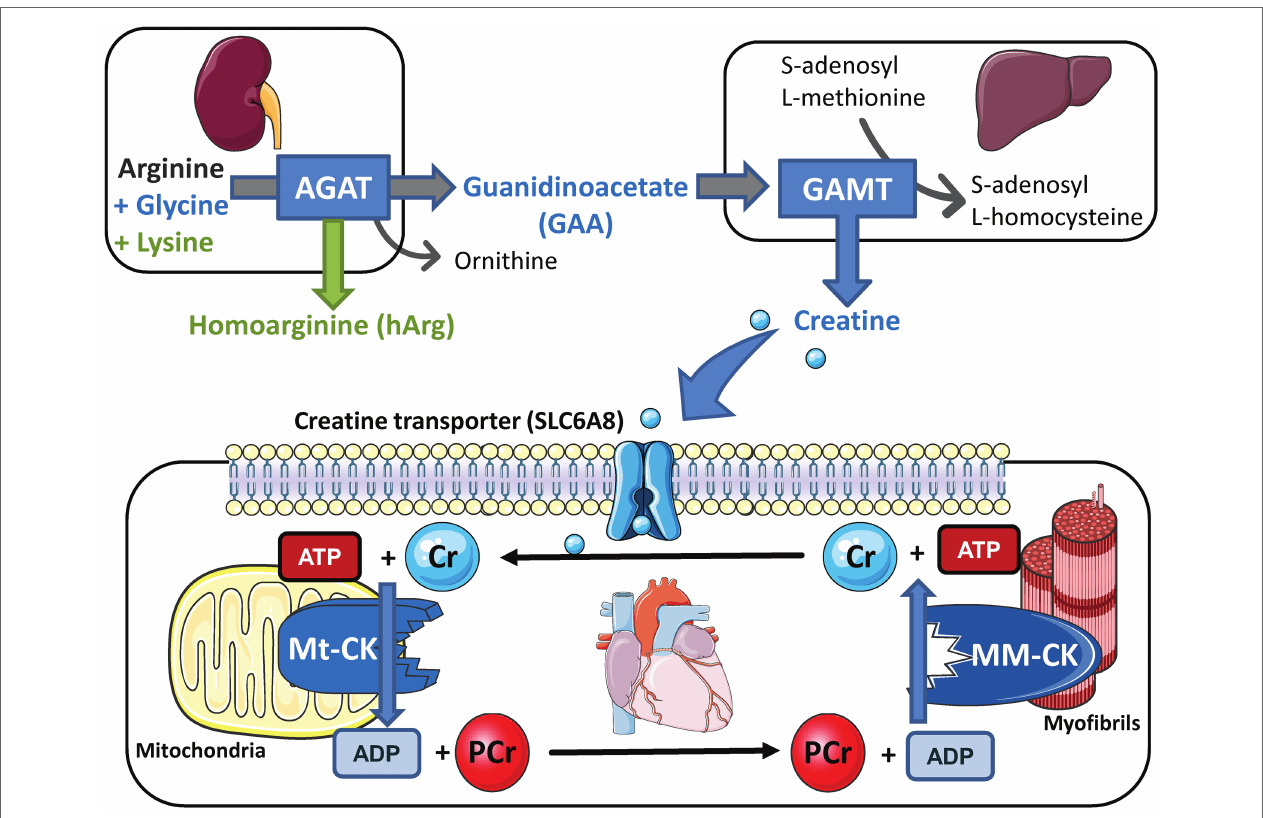
FIGURE 1 | Creatine biosynthesis and the myocardial creatine kinase (CK) phosphagen system. Arginine:glycine amidinotransferase (AGAT; EC 2.1.4.1) is predominantly expressed in the kidneys where it combines arginine and glycine to make guanidinoacetate (GAA) or with lysine to make homoarginine (hArg). Circulating GAA is taken up by the liver where GAA N-methyltransferase (GAMT; EC 2.1.1.2) utilises the methyl group from S-adenosyl L-methionine to synthesise creatine. These biosynthetic enzymes are not expressed in cardiomyocytes so creatine must be taken-up via a specific plasma membrane creatine transporter (SLC6A8). Creatine accumulates inside the cell where the sarcomeric mitochondrial isoform of creatine kinase (MtCK; EC:2.7.3.2) catalyses the transfer of a phosphoryl group from ATP to form phosphocreatine (PCr) and ADP. PCr is a high abundance and mobile energy source that can be utilised to rapidly regenerate ATP at times of high demand under the control of the muscle isoform of creatine kinase (the dimer MMCK; EC 2.7.3.2). Free creatine diffuses back to stimulate further oxidative phosphorylation and re-start the cycle. Knockout models exist for all five of these proteins and overexpression models for CK and creatine transporter (CrT). This figure was created using Servier Medical Art by Servier, which is licensed under a Creative Commons Attribution 3.0 Unported License